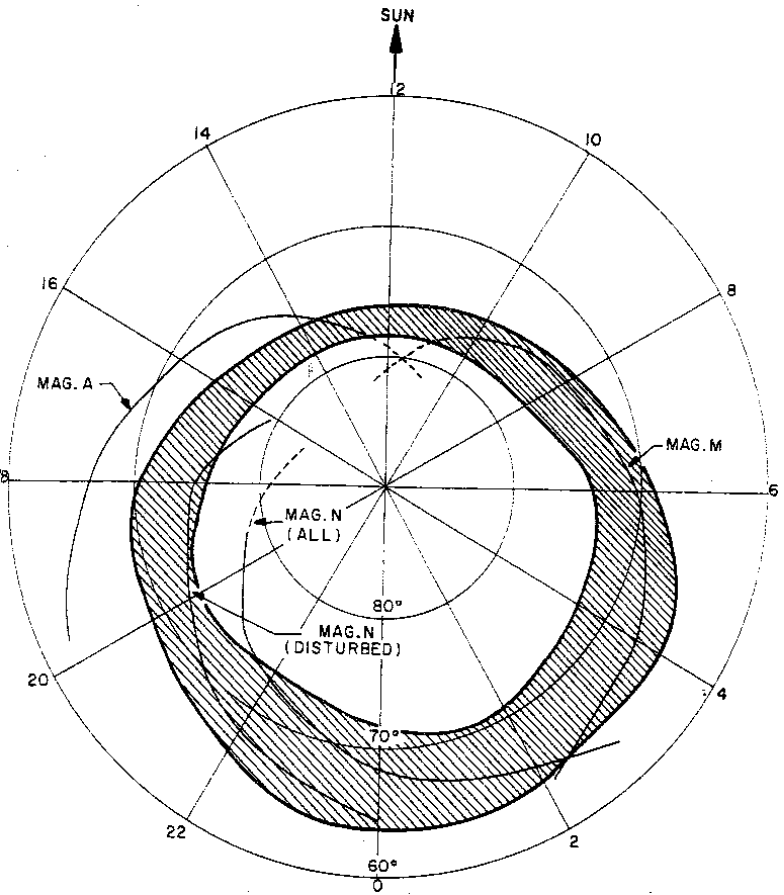
Figure 7. The M-, N- and E-spirals determined by Feldstein (1963a) and the auroral oval by Feldstein (1963b) in dipole latitude and time coordinates (from Akasofu, 1968, Fig.